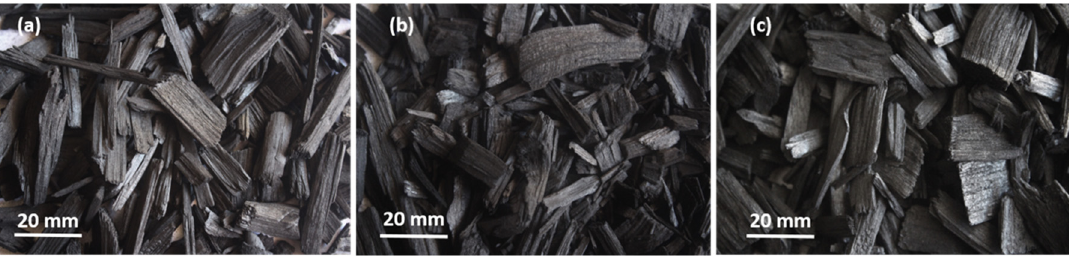
Figure 3. ( a ) Series 1: T1; ( b ) Series 1: T2; and ( c ) Series 1: T3 presenting the darkest hue.